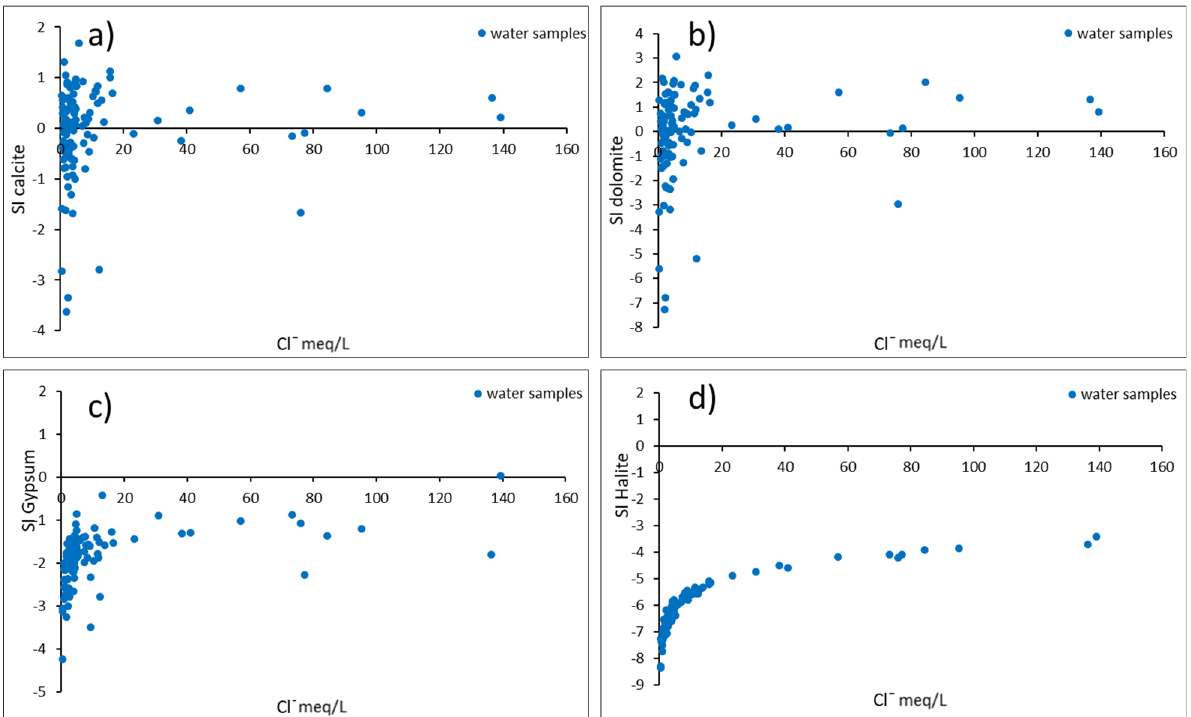
Figure 10. Saturation index for calcite ( a ), dolomite ( b ), gypsum ( c ) and halite ( d ) versus Cl − con- centration.